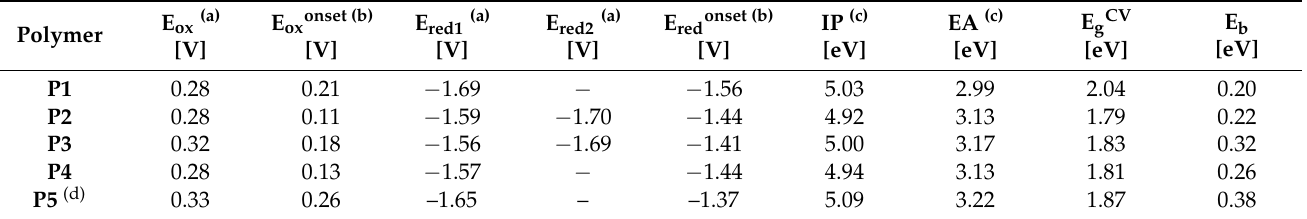
(a) peak potentials determined from DPV, the potential values given vs. Fc/Fc + . (b) E onset were determined from CV, the potential values given vs. Fc/Fc + . (c) IP = |e| · (1.15 · E oxonset + 4.79) eV, EA = e · (1.18 · E redonset + 4.83)